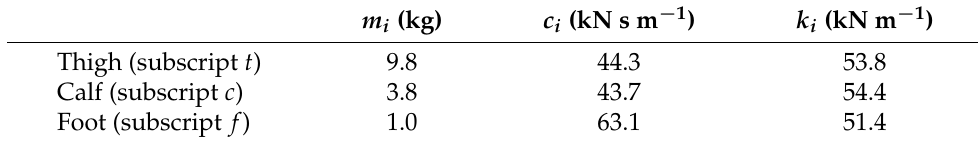
Table 2. Numerical values for the human lower limb model of Figure 6, adapted from Ref.